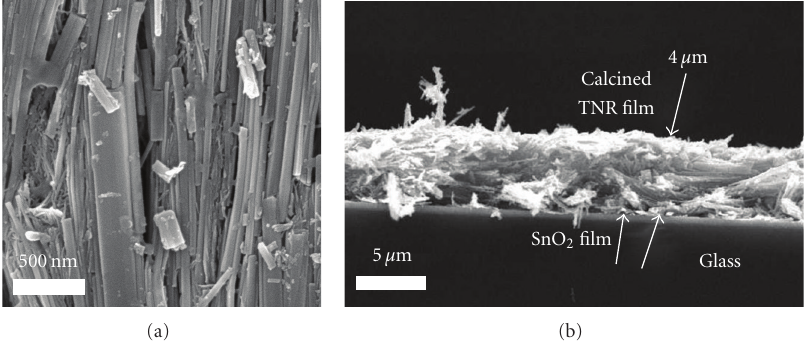
Figure 4: Surface (a) and cross section (b) SEM images of TNR/SnO 2 film calcined at 600 ◦ C for 2h.